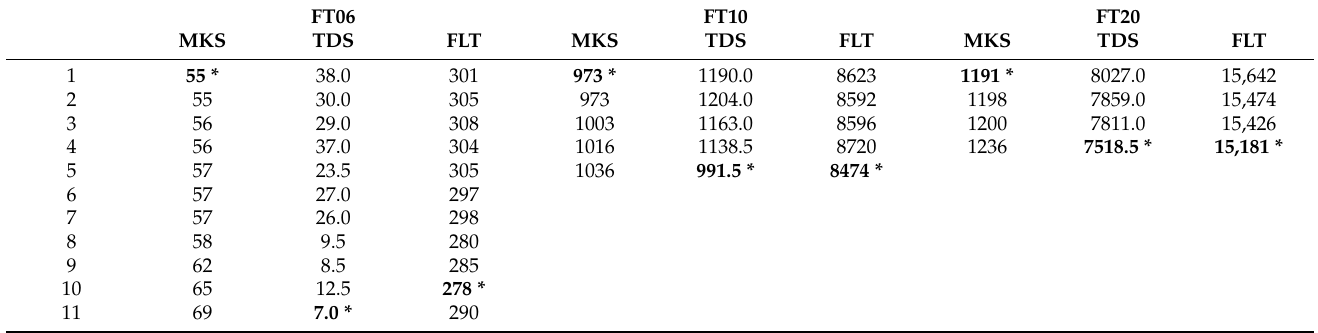
Table A7. Non-dominated solutions obtained by SS/CMOSA for the JSSP instances proposed by